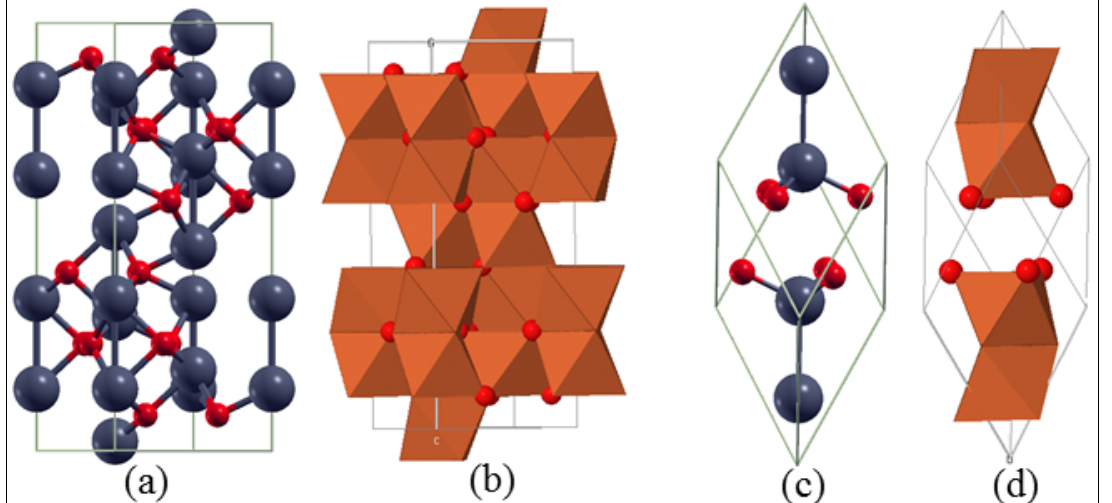
Figure 2. Schematic illustration of the ( a ) hexagonal unit cell and ( c ) the rhombohedral primitive cell of α-Fe O . The face-sharing octahedra in ( a ) and ( c ) are shown in ( b ) and ( d ) 2 3 respectively. Color scheme: Fe = grey and O =